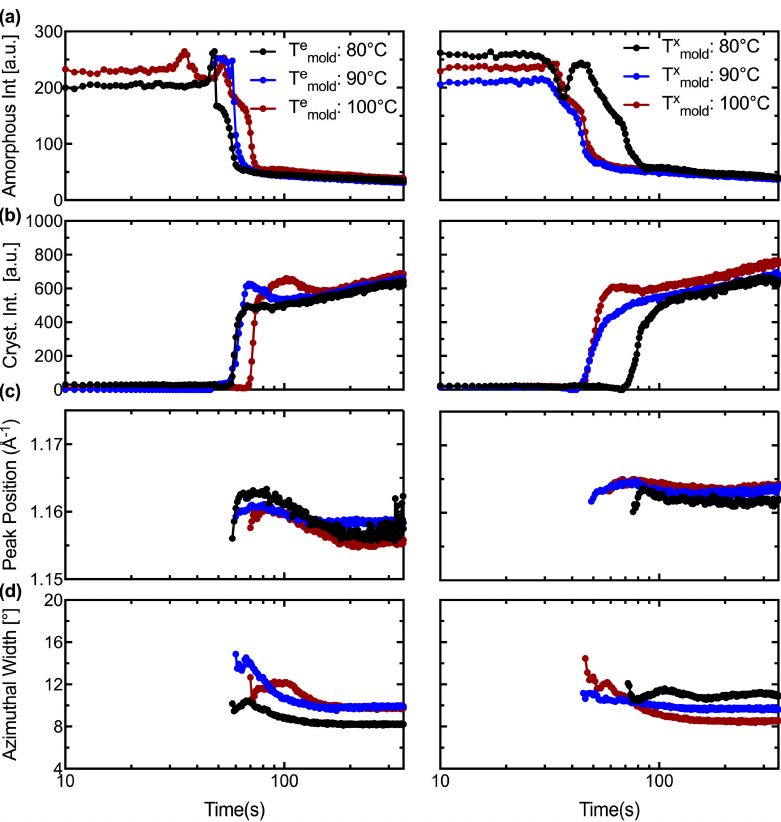
Figure 7. Quantitative characteristics of 1D WAXS profiles for expansion performed at: ( left ) T e mold = 80, 90 and 100 ◦ C; and ( right ) T x mold = 80, 90 and 100 ◦ C. The variation in: ( a ) amorphous content; ( b ) crystallinity; ( c ) peak position of the (110)/(200) peaks; and ( d ) full width at half maximum of the (110)/(200) peaks is presented during the heating and the annealing steps (t ≤ 350 s); quantitative analysis for the cooling step is presented in the Supplementary Materials (Figure S21).